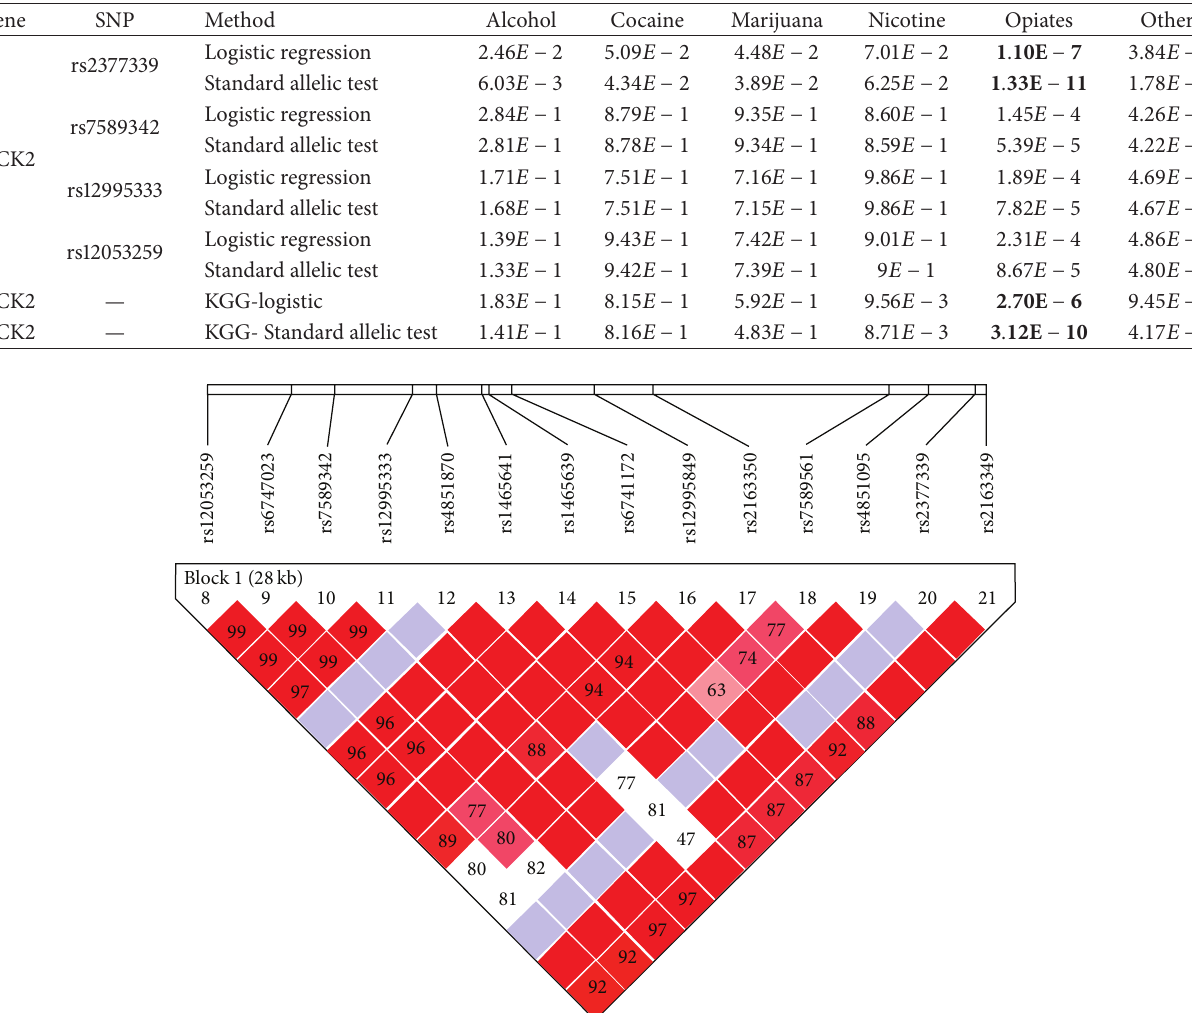
Table 2: Association of the most significant SNPs in the NCK2 gene with the six substances dependence in African-origin sen.